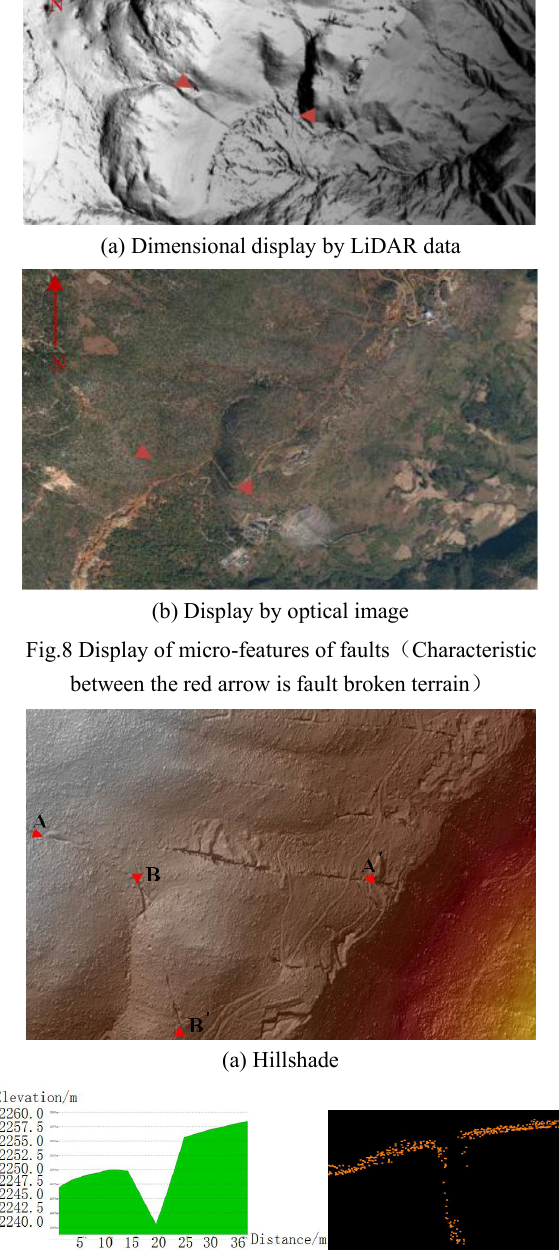
Fig.9 Identification and micro-feature information of fissures For early geomorphologists, field observations were central to investigate the fault fracture and local surface active fault zones in the scale of meters and centimeters, combined with surveying difficulties (poor line of sight and limited GPS